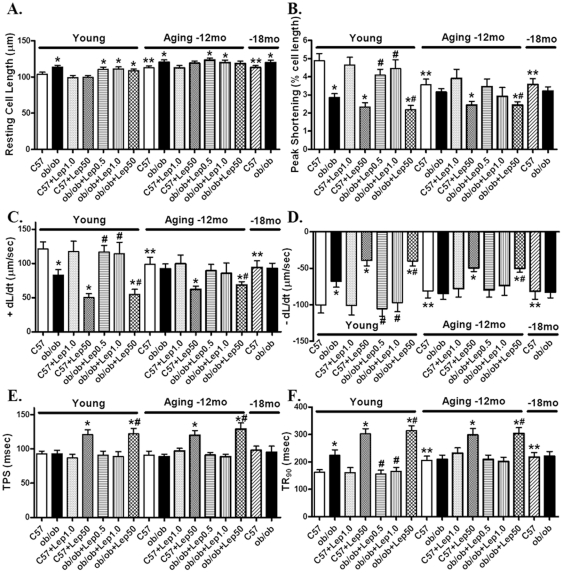
Contractile properties of cardiomyocytes freshly isolated from young
(4-month-old) and aging (12- or 18-month-old) lean (C57) and
ob/ob mice treated with or without leptin (0.5, 1.0
and 50 nM) for 4 hrs.A: Resting cell length; B: Peak shortening (PS, normalized to cell
length); C: Maximal velocity of shortening (+ dL/dt); D:
Maximal velocity of relengthening (- dL/dt); E: Time-to-peak shortening
(TPS); F: Time-to-90% relengthening (TR90); Mean
± SEM, n = 50–53
cells from 3 mice per group, * p<0.05
vs. respective C57 group, **
p<0.05 vs. young C57 group, # p<0.05
vs. respective ob/ob group.